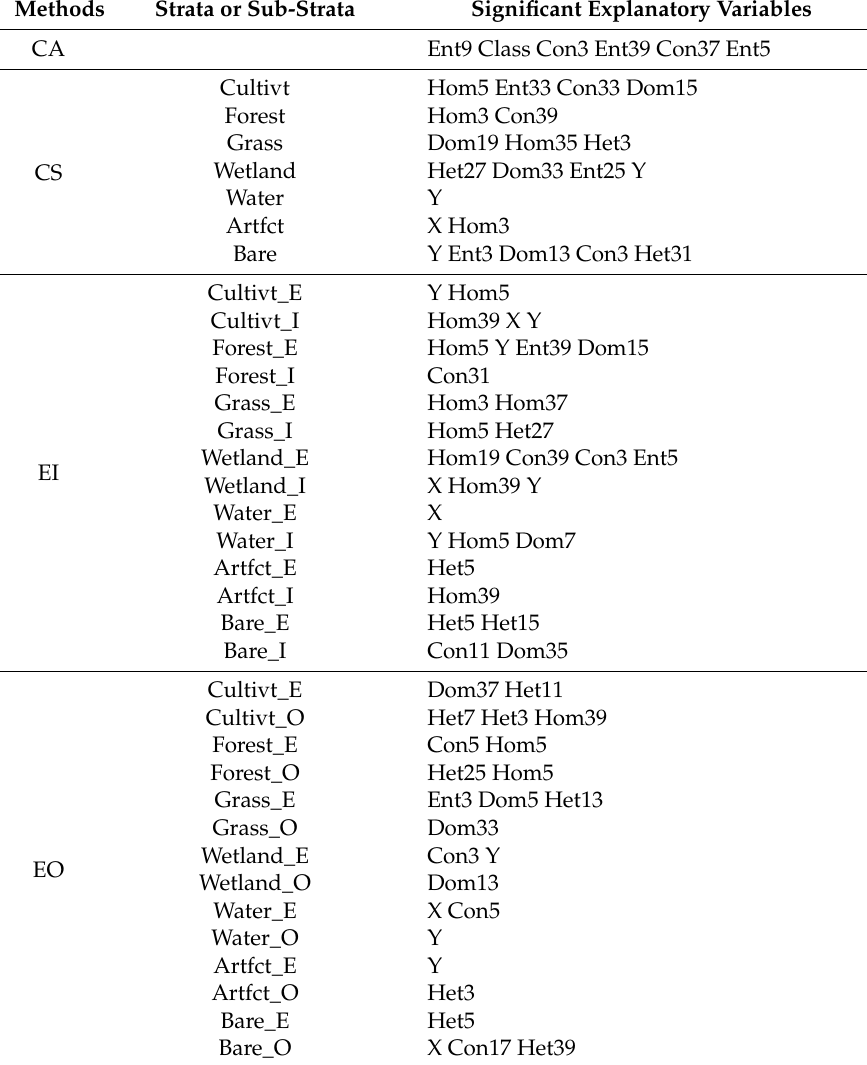
Table 4. Optimal models with significant explanatory variables for different